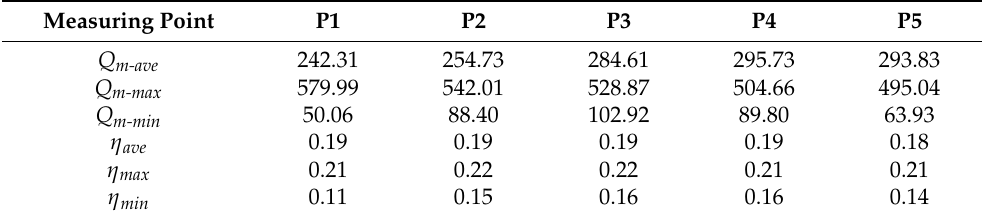
Figure 19. The ventilation quantity by thermal pressure and wind pressure at P1. Figure 19 shows the effect of ventilation volume caused by hot pressure and wind pressure at measuring point 1. Ten sets of data are selected for calculation every day. It can be seen that the ventilation volume caused by wind pressure is very small. In the vertical direction, the ventilation quantity due to thermal pressure is stable, while in the horizontal direction, the total ventilation quantities of east and west are greater than the middle. Moreover, the ventilation volume of the topmost floor is larger than that of the lower floor. 6. Conclusions In this paper, the near-wall microclimate of the three buildings in Zhengzhou was measured in winter and summer, trying to find the variation law of outdoor temperature and attached airflow velocity with height. Through the establishment of a typical heat